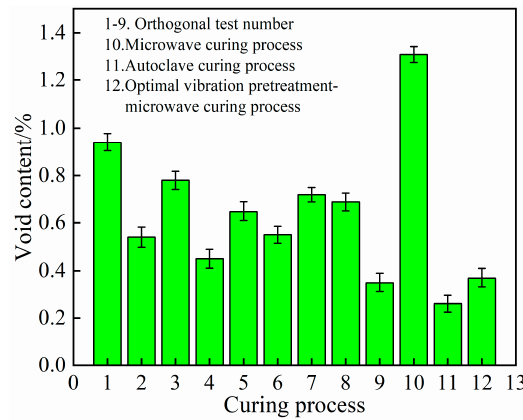
Figure 5. Void content of different curing processes.